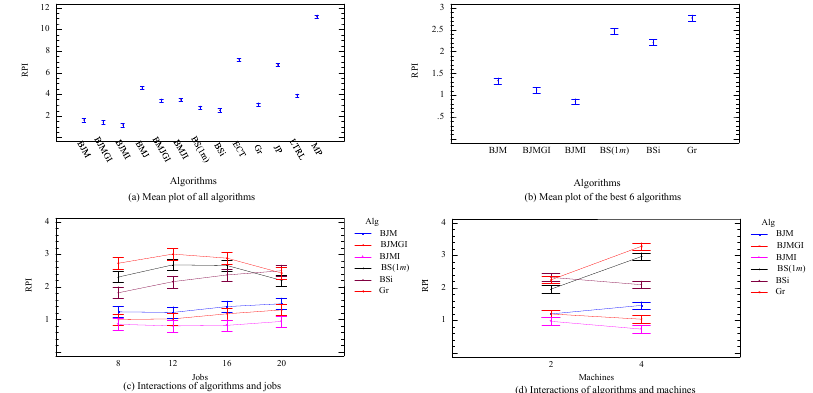
Fig. 7. Means plots, interactions and 95.0% Tukey HSD intervals of ARPI (small